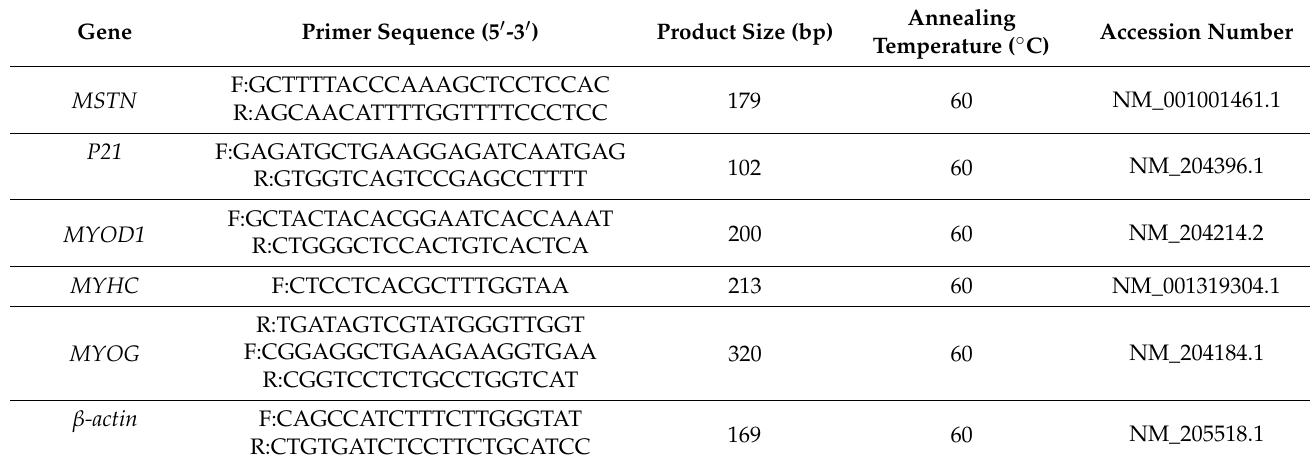
Table 2. Gene primers used for qRT-PCR.